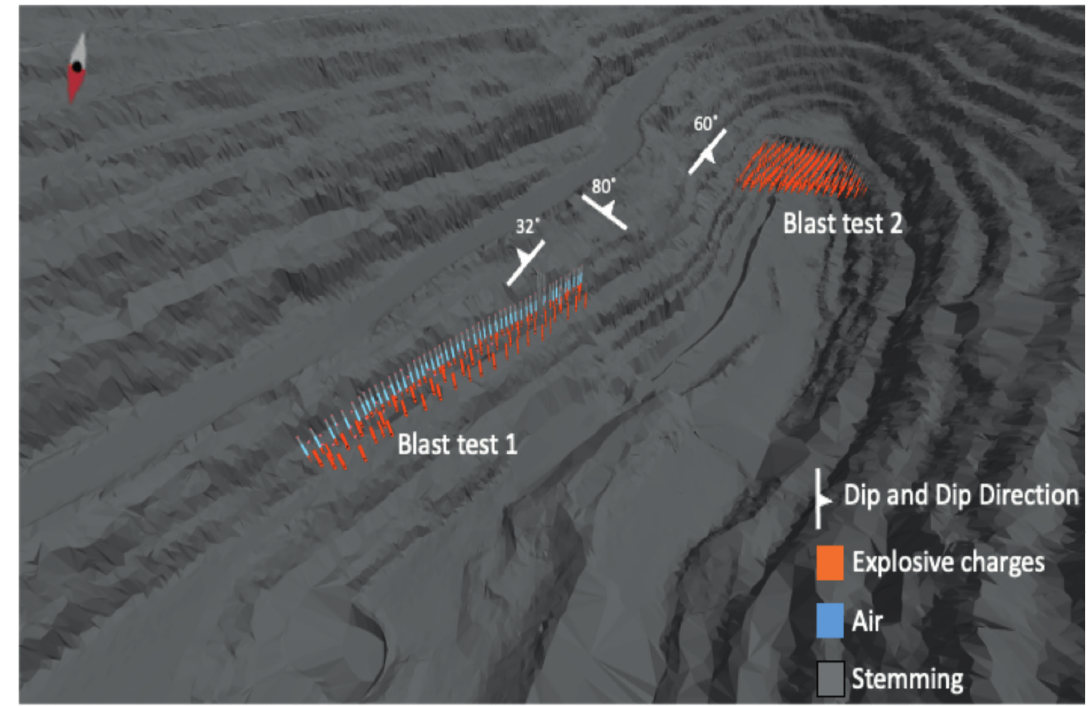
Figure 6. Area of the blast tests and their direction and dip direction of the region’s main discontinuity